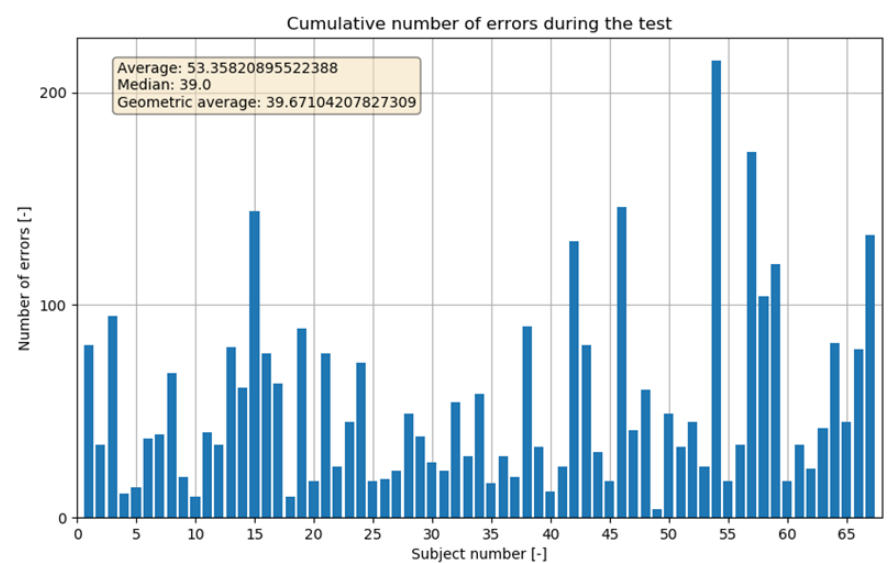
Figure 12. Cumulative number of errors during the test.